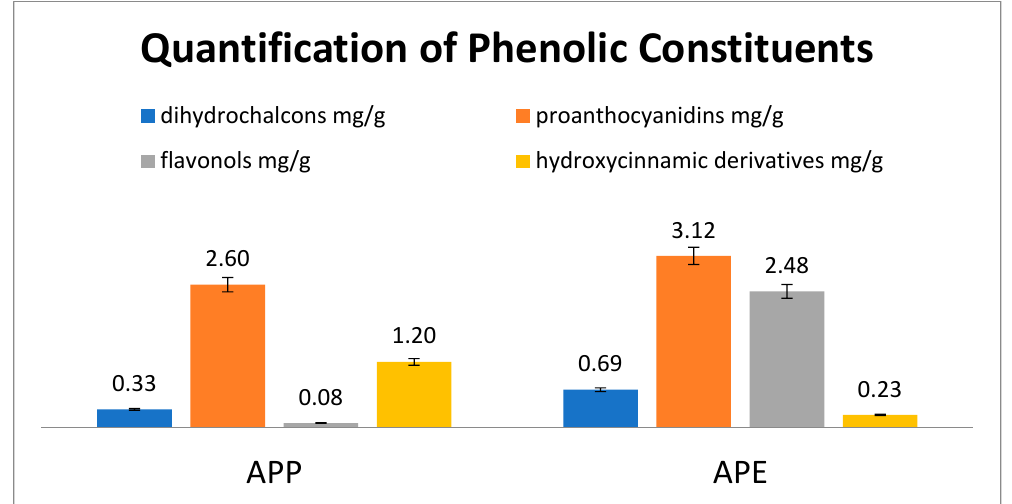
Figure 1. HPLC (High performance liquid chromatography) chromatogram of apple pulp (APP) at 254 nm ( A ), with chemical structures of the main constituents ( B ). LC-APCI-MS (liquid chromatography atmospheric pressure chemical ionization mass spectrometry) chromatogram of apple peel (APE) extract showing a peak related to annurcoic acid ( C ).